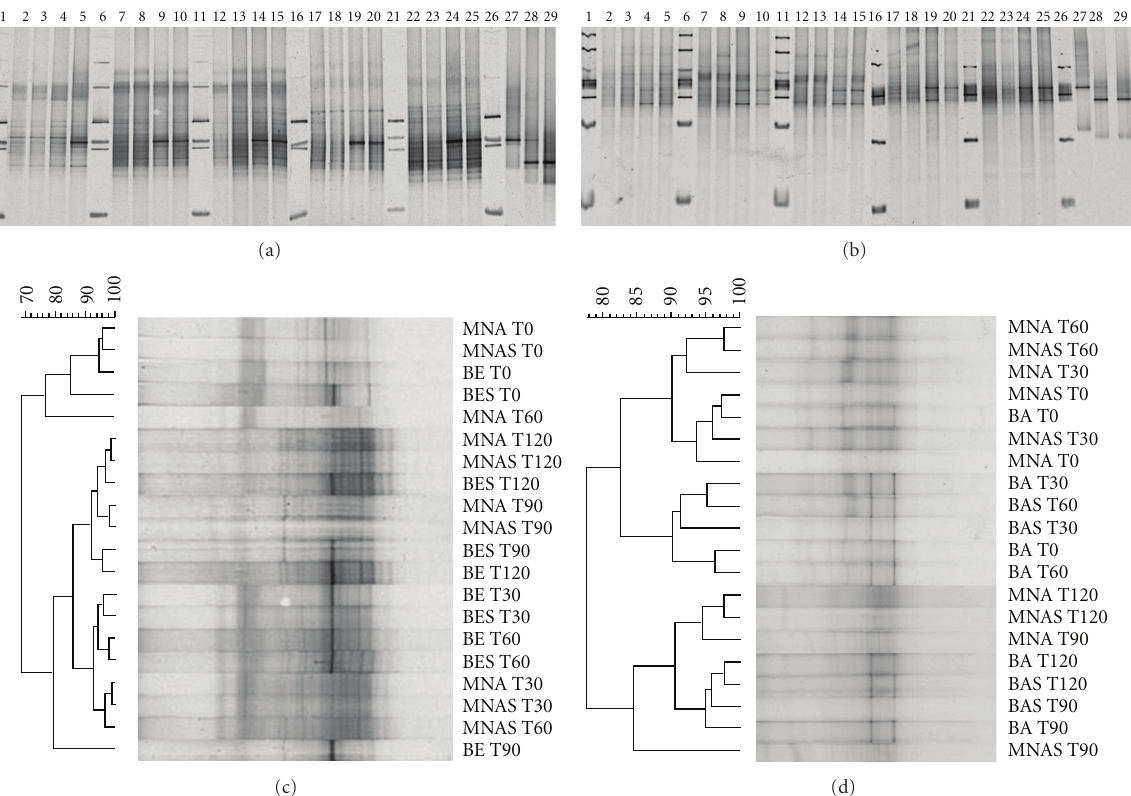
Figure 1: Denaturing gradient gel electrophoresis (DGGE) fingerprints of bacterial 16S rRNA gene fragments amplified from Cantagalo (a) and Panelas (b) microcosms submitted to di ff erent bioremediation treatments and sampled after 0, 30, 60, 90, and 120 days. Lanes: (1, 6, 11, 16, 21 and 26) 1 Kb ladder, (2) MNA T0, (3) MNAS T0, (4) BE/BA T0, (5) BES/BAS T0, (7) MNA T30, (8) MNAS T30, (9) BE/BA T30, (10) BES/BAS T30, (12) MNA T60, (13) MNAS T60, (14) BE/BA T60, (15) BES/BAS T60, (17) MNA T90, (18) MNAS T90, (19) BE/BA T90, (20) BES/BAS T90, (22) MNA T120, (23) MNAS T120, (24) BE/BA T120, and (25) BES/BAS T120. Strains used for the bacterial consortium: (27) Gordonia alkanivorans DLB 3.22, (28) G. rubriperctinta DTSB 2.5, and (29) Rhodococcus equi DLB 2.6. GelCompar II 4.06 software was used to generate the dendrogram based on the DGGE clustering profiles of the soils from Cantagalo (c) and Panelas (d) using Pearson’s coe ffi cient and the clustering method of